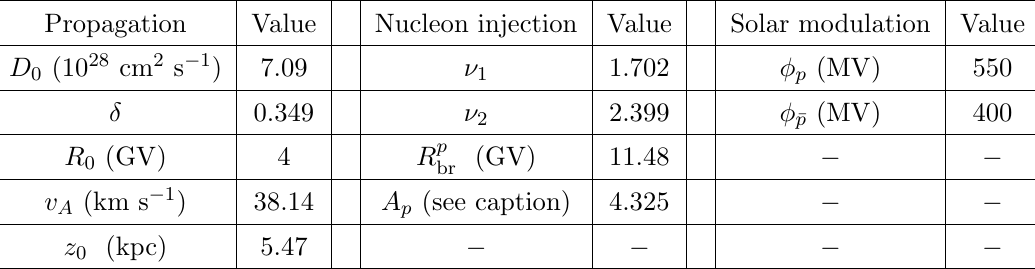
Table 1 . Parameters of propagation, nucleon injection and solar modulation and their values adopted in our numerical analysis. The proton (cid:13)ux is normalized to A p at 100 GeV in the units